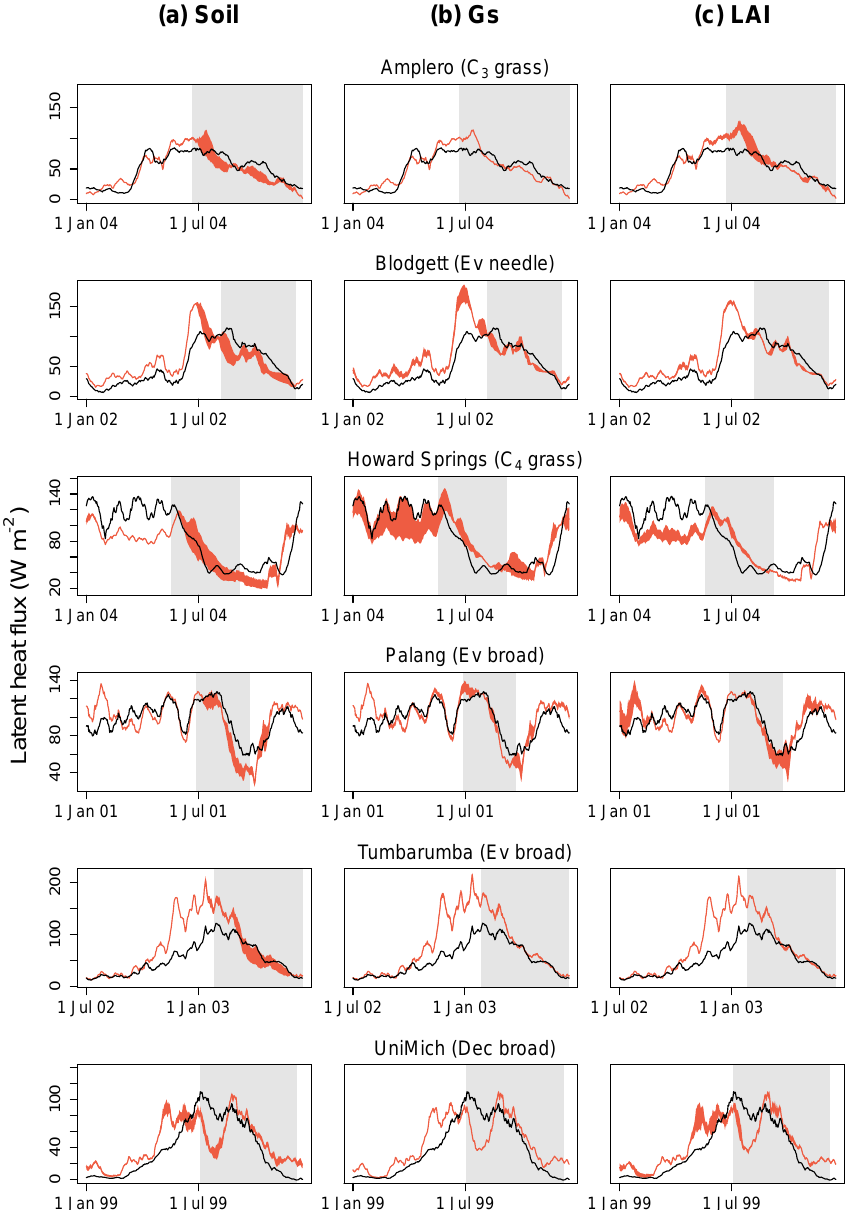
Figure 7. The range in simulated latent heat (red) arising from the individual effects of soil parameters (left panel), g s (centre panel) and LAI (right panel) using the new hydrological scheme during the 1-year period. Observed latent heat is shown in black. The grey shading denotes the selected dry-down period. The individual effects were determined by fixing the other parameterisations at their default values (medium soil, Medlyn g s , centre LAI and 0 ◦